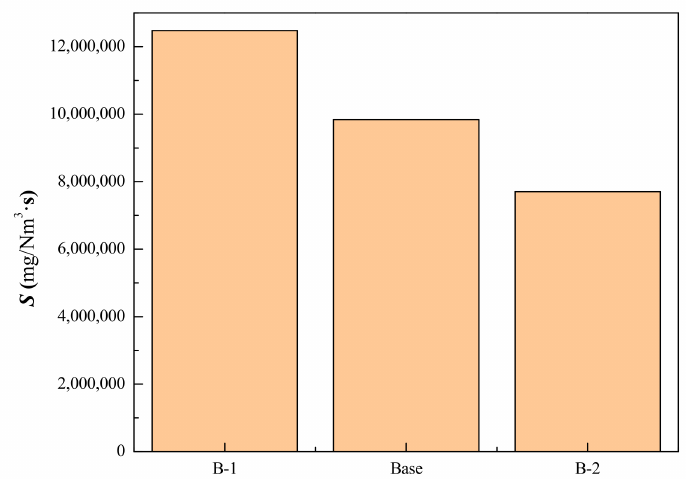
Figure 6. Influences of the ratio of CTC in the sintering mixture on CO emission. (The ratios of CTC: B-1 = 1.8; Base = 2.0; B-2 = 2.2).